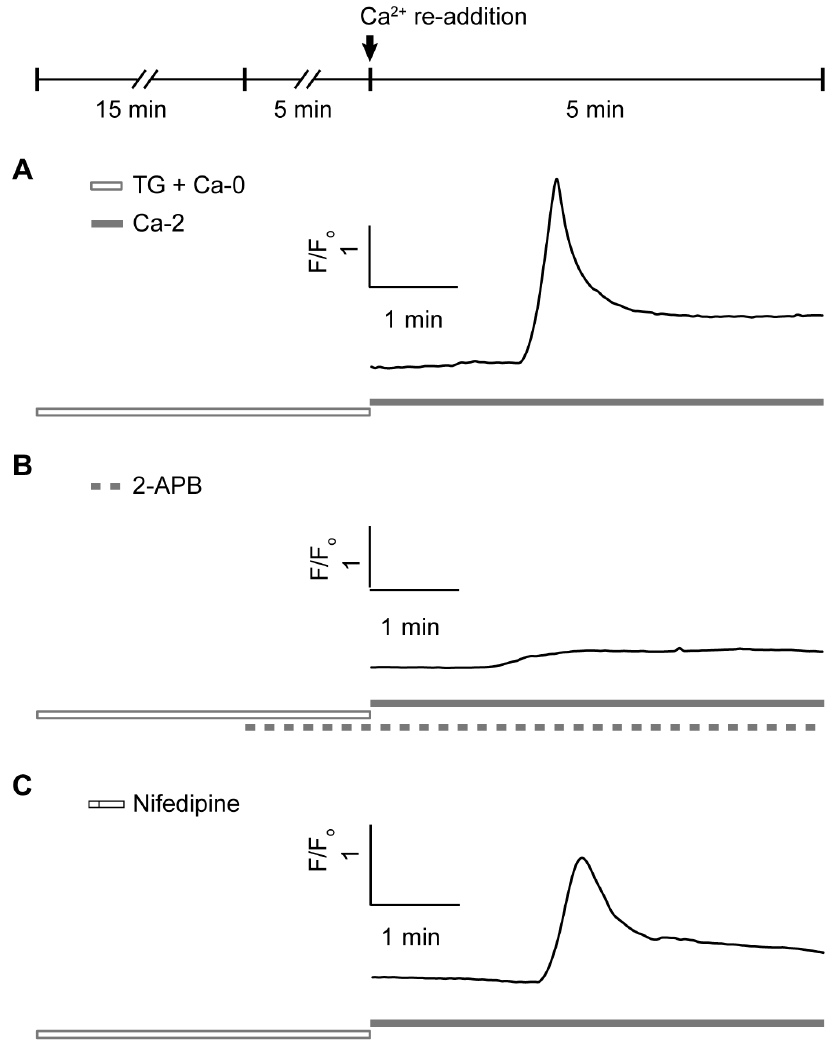
Figure 4. SOCs were nessicary for ER depletion-induced Ca 2 + entry. A, After pre-application of thapsigargin (TG, 5 m M) in Ca 2 + -free Ringer’s solution for 20 min to deplete ER, reintroduction of [Ca 2 + ] o (2 mM) elicited a transient increase in [Ca 2 + ] i . B, In the presence of 2-APB (a SOC inhibitor, 100 m M), the [Ca 2 + ] i increase induced by [Ca 2 + ] o re-addition was abolished. C, In the presence of nifedipine (a L-VGCC blocker, 100 m M), the [Ca 2 + ] i increase after [Ca 2 + ] o re-addition was still observed. Abbreviations: Ca-0: Ca 2 + -free; Ca-2:2 mM [Ca 2 + ] o . Traces shown are representative of three independent experiments, eight HCs were tested under each